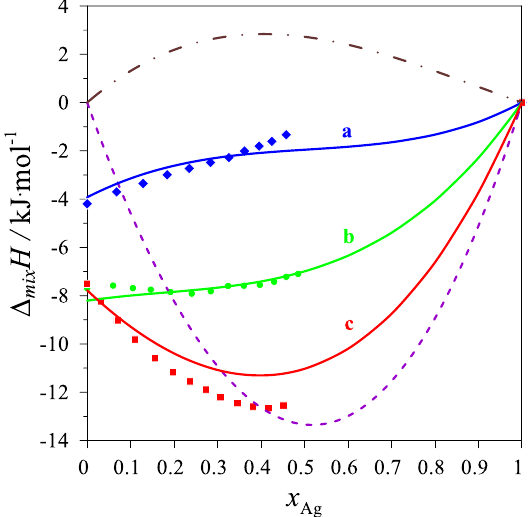
Figure 2. The integral mixing enthalpy of liquid Ag-Mg-Pb alloys at 1116 K, for the following intersections: (a)—Series A (Mg 0.25 Pb 0.75 ) 1 − x Ag x —blue line: data calculated with Equation (4), blue diamonds—experimental data; (b)—Series B (Mg 0.50 Pb 0.50 ) 1 − x Ag x —green line: data calculated with Equation (4), green circles—experimental data; (c)—Series C (Mg 0.75 Pb 0.25 ) 1 − x Ag x —red line: data calculated